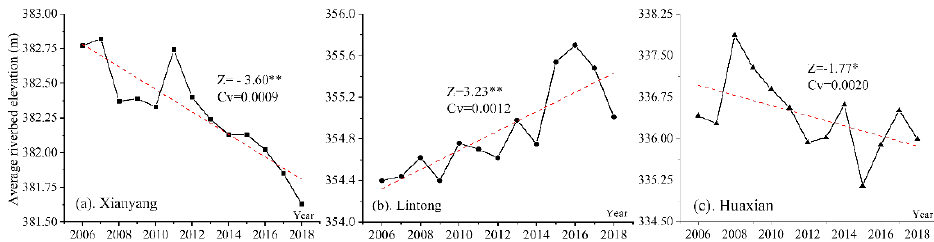
Figure 5. The average elevation of the main channel in: ( a ) Xianyang station; ( b ) Lintong station; and ( c ) Huaxian station post − flood − section in 2006 – 2018. The dashed lines indicate the trend line; the Z statistic was obtained from the Mann – Kendall test. (**: p < 0.01, *: p < 0.05).